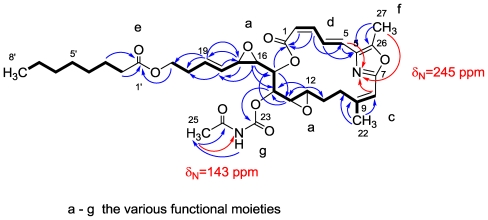
COSY (—), and key 13 CH- and 15NH-HMBC correlations of salarin C.